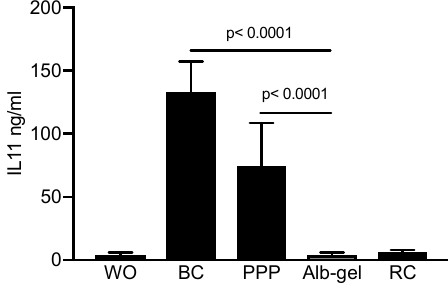
Figure 3. PPP and buffy coat but not heated PPP caused the accumulation of IL11 in the oral fibroblast cells supernatant. Gingival fibroblasts were exposed to 30% of the respectively lysates prepared from PPP, heated PPP (75 °C for 10 min; Alb-gel), and buffy coat (BC). For red clot, 5% of the lysates was used. The levels of IL11 in the supernatant of the fibroblasts is presented in ng/mL. Bar graphs show the means and standard deviation of three independent experiments (N = 3). Statistical analysis was based on an ANOVA with a multiple comparison against heated PPP based on Fischer’s LSD test.